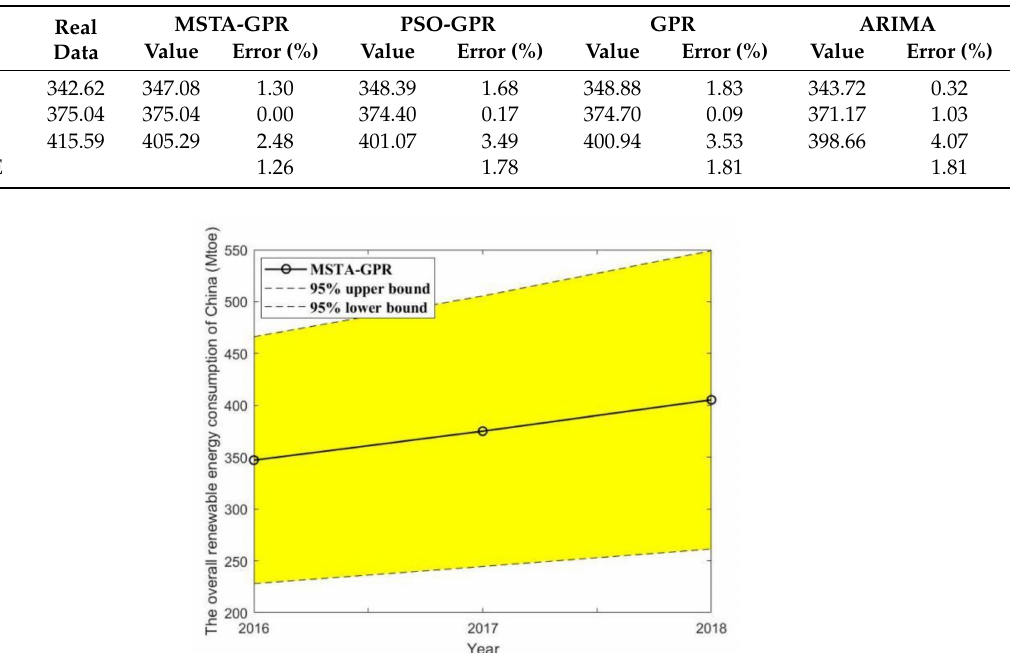
Figure 3. The interval prediction result of MSTA-GPR for overall renewable energy consumption in